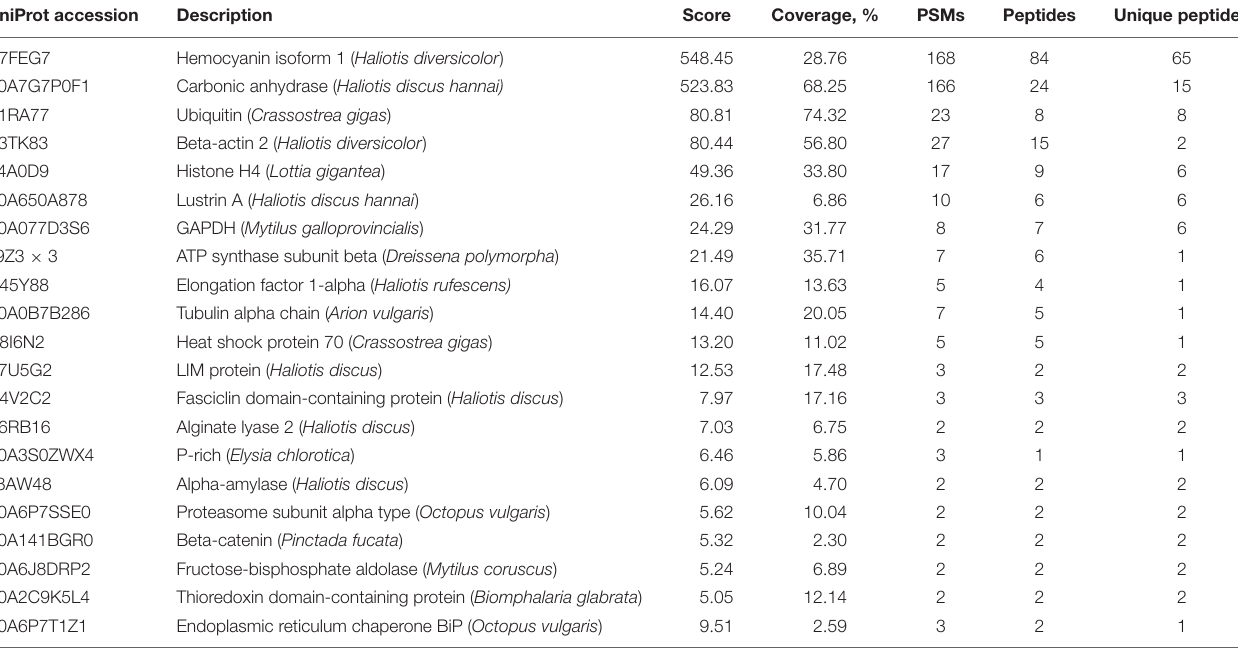
TABLE 1 | Proteomic analysis of shell matrix proteins extracted from toasted abalone shells at 300 ◦ C for 10 min. UniProt accession Description Score Coverage, % PSMs Peptides Unique